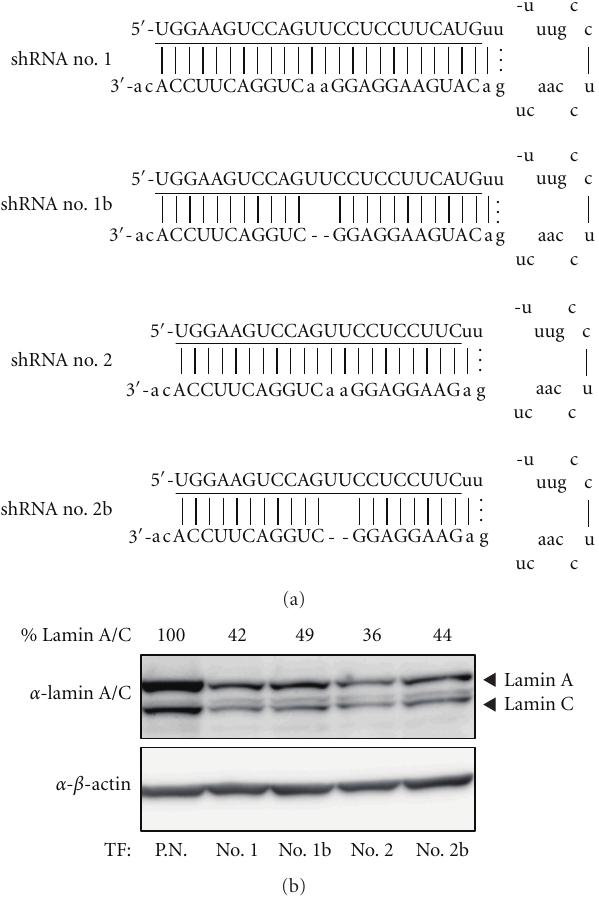
Figure 1: Design of pre-miRNA-based shRNAs and their RNAi activity. (a) The set of four synthetic shRNAs containing a 21 or 24bp stem, either with or without a 2bp deletion of the 3 (cid:3) arm, is represented. The underlined sequences are complementary to the LMNA mRNA sequence. The lower cases are derived from the human pre-miR-155 sequence. (b) The RNAi activity of these shRNAs targeting LMNA was analyzed by immunoblotting. TF is the abbreviation for